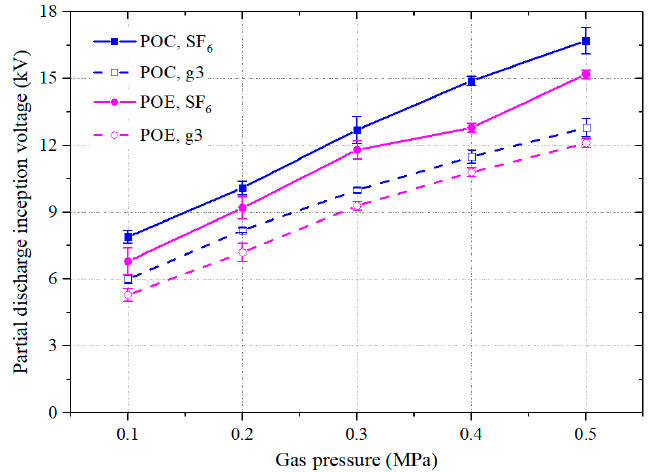
Figure 3. Partial discharge inception voltages (PDIVs) of SF 6 and g3 in the POC and POE at different pressures.